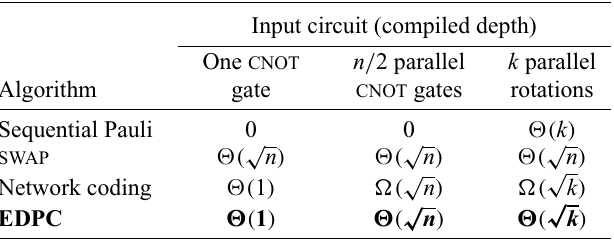
TABLE I. A comparison in the depth of surface code compi- lation algorithms [that use (cid:3)( n ) space] for various input circuits of width n . We compare the worst-case performance for a single long-range CNOT gate, for CNOT circuits with n / 2 parallel CNOT gates, and for k rotations with k ∈ N that need to be performed at the